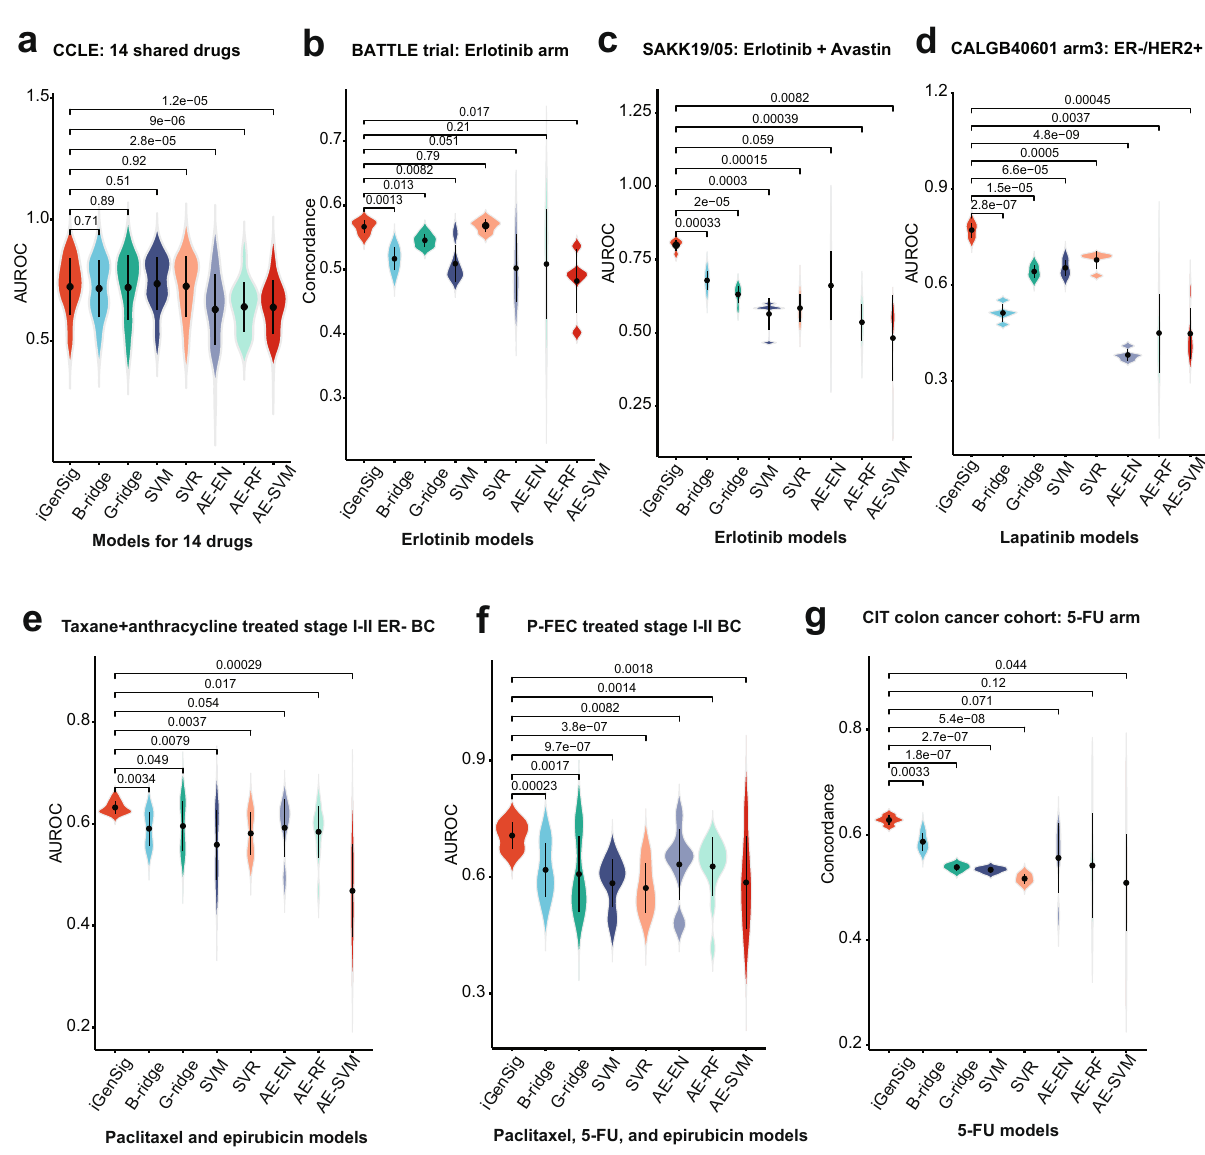
Fig. 7 Comparisons between the iGenSig algorithm and standard machine learning algorithms on modeling drug responses. a The Prediction performance of the iGenSig algorithm and machine learning methods on the CCLE validation dataset for 14 drugs. If a drug is pro fi led by both GDSC batch 1 and 2, the drug sensitivity data from batch 1 are used in the analysis. b – g The Prediction performance of the iGenSig algorithm and machine learning methods on US BATTLE trial ( b ), Swiss SAKK 19/05 trial ( c ), CALGB40601 trial ( d ), neoadjuvant taxane-anthracycline study ( e ), neoadjuvant P-FEC study ( f ), and the French CIT colon cancer clinical study ( g ). The predictive models for the respective drugs annotated under each plot were generated based on 80% cell lines from GDSC with fi ve permutated training sets. For ML methods, the supervised learning was directly performed on the original high- dimensional genomic features using Gaussian family ridge regression (G-ridge) and support vector regression (SVR) based on drug sensitivity measurements or using Binary family ridge regression (B-ridge) and support vector machine (SVM) based on binary sensitivity labels. For AI methods, the unsupervised learning was performed by autoencoder (AE) and supervised learning was performed using various machine learning tools including elastic net (EN), random forest (RF), and support vector machine (SVM) based on binary sensitivity labels. The p values are based on two-sided student ’ s t -tests. The AUROC for predicting patient binary responses (pCR for breast cancer clinical studies or objective response for the SAKK 19/05 trial) or the concordance of the predictive scores with patient survival (PFS for the BATTLE trial and OS for the CIT cohort) are shown in the fi gure depending on the best available clinical endpoints for these studies. The mean and standard deviations are shown in the violin